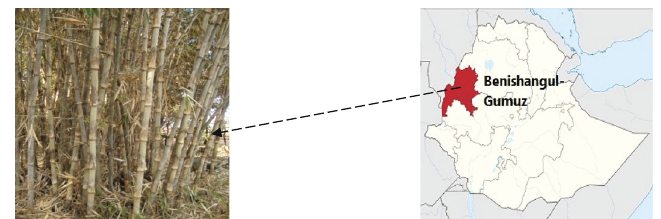
Figure 1: In a region in Ethiopia, Oxytenanthera abyssinica was